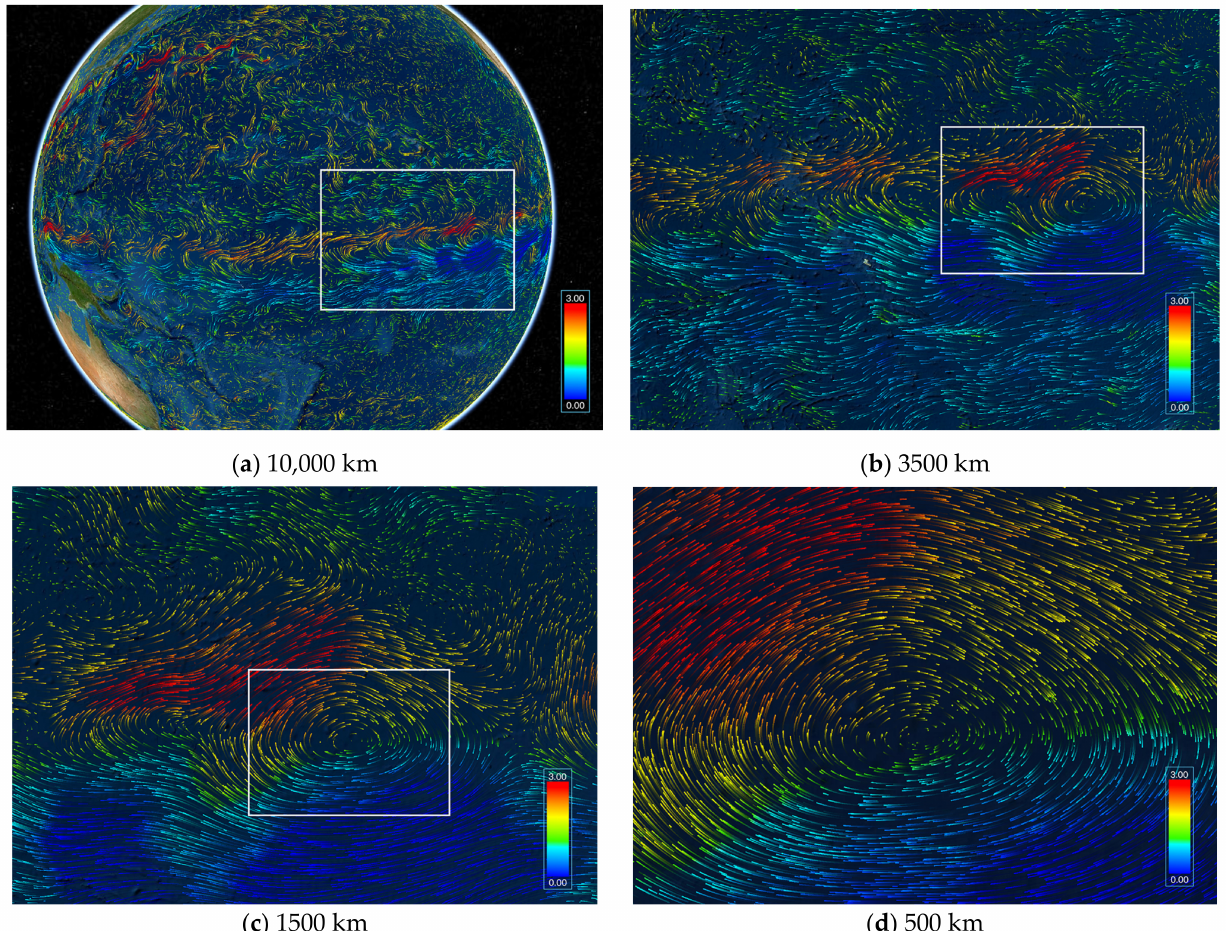
Figure 12. Rendering results at different viewing distances. ( a ) is the rendering result at 10,000 km; ( b ) is the rendering result at 3500km; ( c ) is the rendering result at 1500 km; and ( d ) is the rendering result at 500